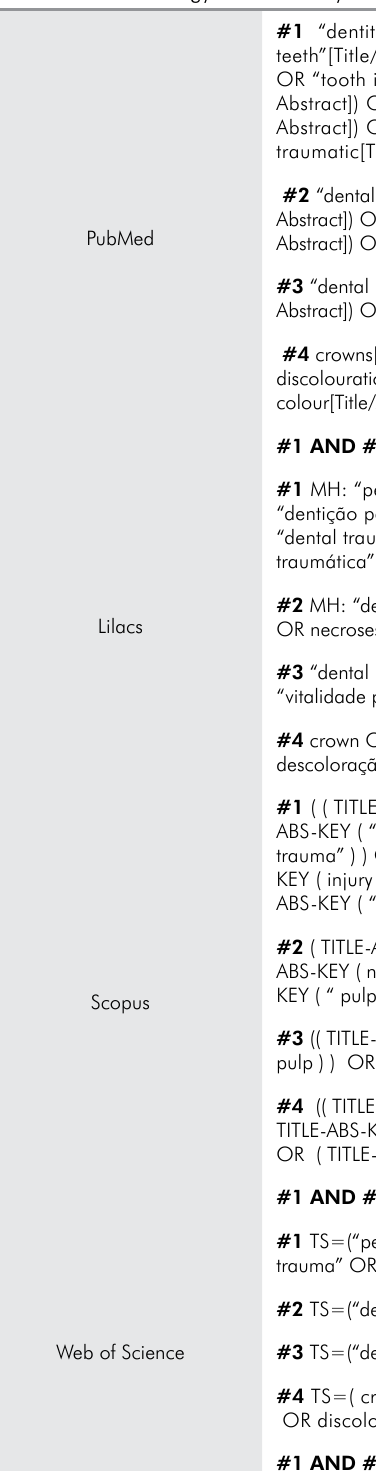
Table 1. Search strategy used in the systematic